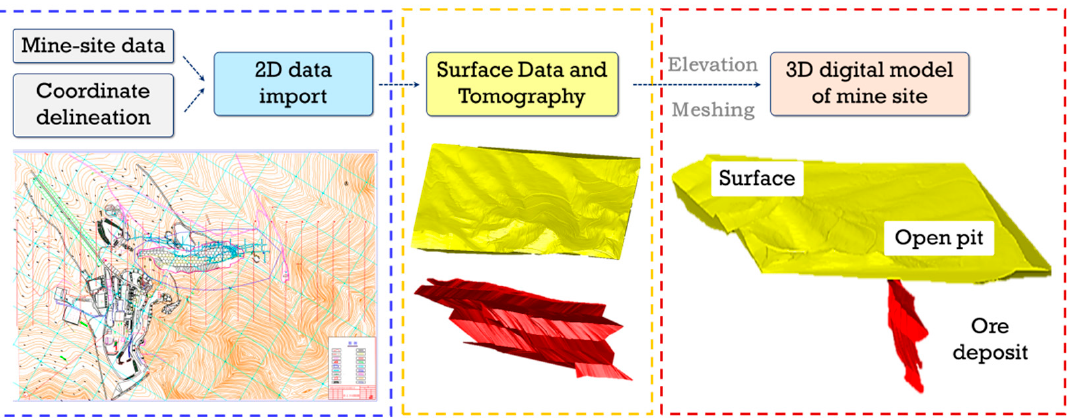
Figure 1. Geological topography and 3D reconstruction of ore bodies in Hongling subsidence area.